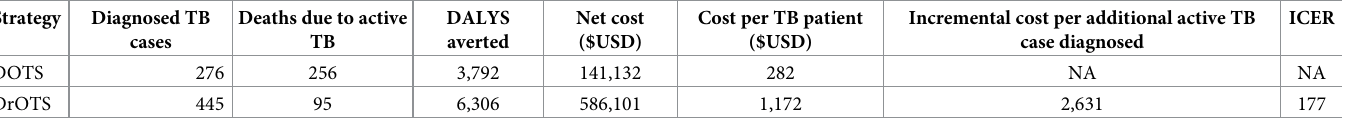
Table 4. Projected outcomes and cost-effectiveness of DOTS and DrOTS for TB control in a 200,000-population remote district of Madagascar. Strategy Diagnosed TB